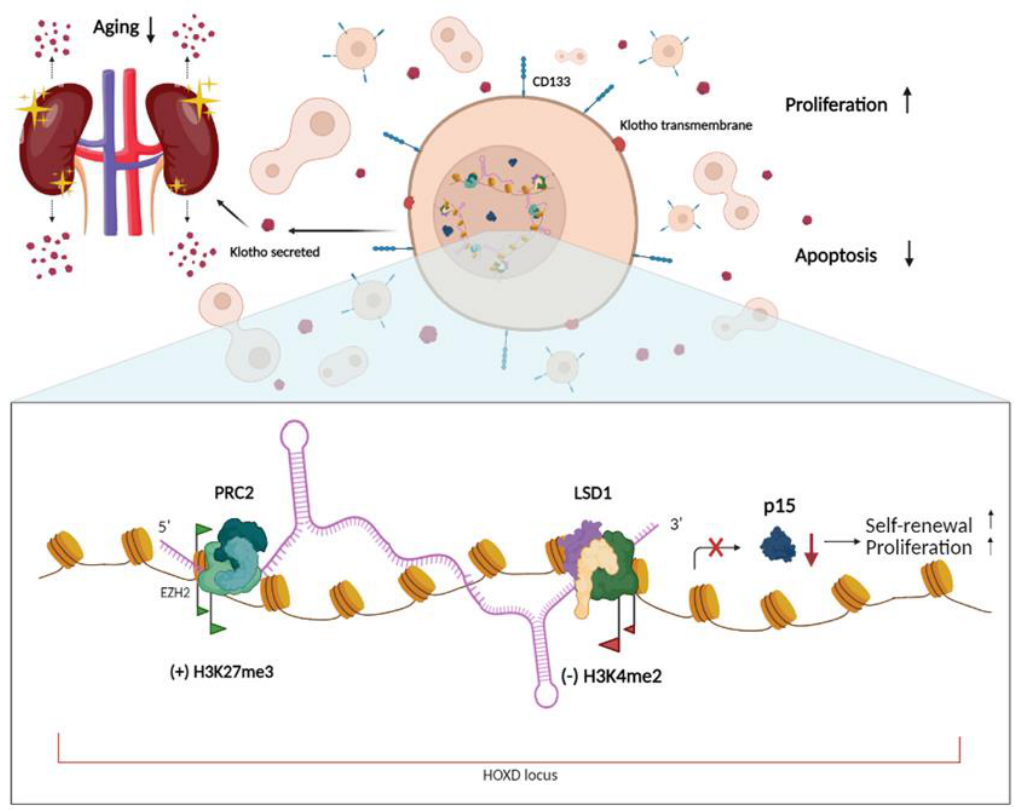
Figure 3. HOTAIR regulates ARPC stemness properties. HOTAIR regulates the proliferation and self-renewal capacity of ARPCs, limits their apoptosis, and regulates CD133 expression, an inverse marker of senescence and functional marker of stemness in ARPCs. HOTAIR also regulates the secretion of α -Klotho, which in turn can influence the surrounding tissues and therefore modulate tissue aging, playing an important role in preventing cells from becoming senescent in the short term. These mechanisms are regulated through p15 epigenetic silencing by HOTAIR. This lncRNA acts as a molecular scaffold to link the PRC2 and LSD1 protein complexes and coordinates the chromatin targeting of these proteins. The complex leads to histone H3K27 trimethylation and H3K4 demethylation in the p15 gene promoter. Trimethylation of H3K27 leads to the silencing of cyclin p15 and helps keep the ARPC cell cycle active, sustaining self-renewal and proliferation. From: Angela